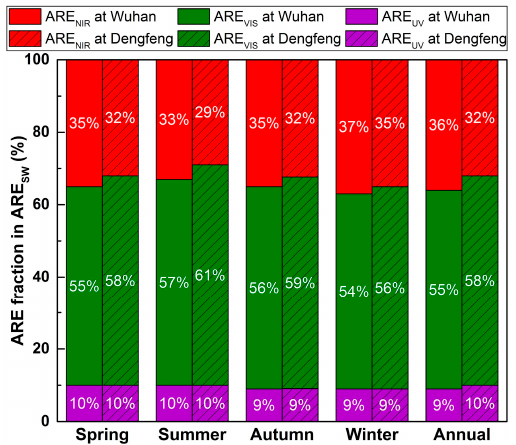
Figure 14. Annual and seasonal average ARE fraction of UV, VIS, and NIR in ARESW in Wuhan and Dengfeng.